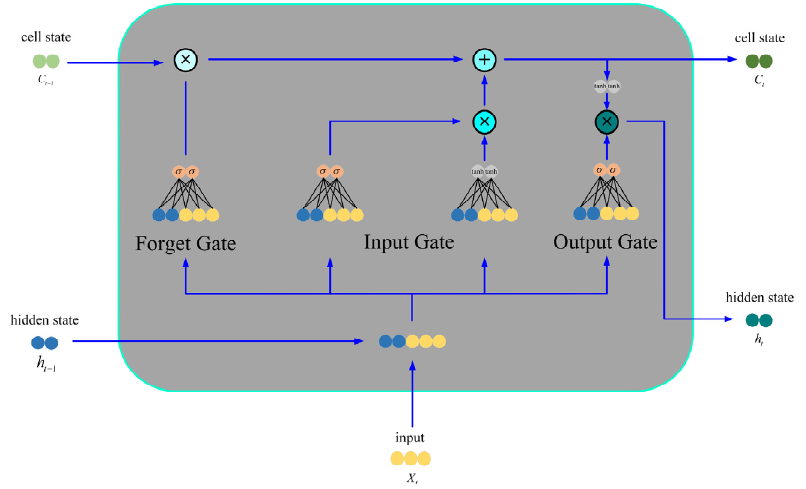
Figure 7. LSTM Cell Diagram.